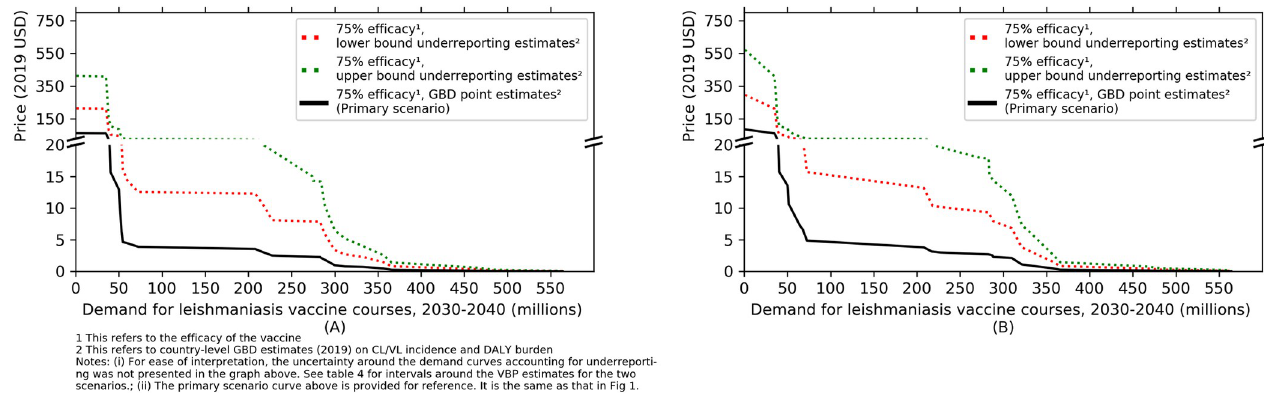
Fig 3. Sensitivity of value-based maximum price to underreporting: (A) assuming treatment coverage = 0%, (B) assuming treatment coverage = 100%.